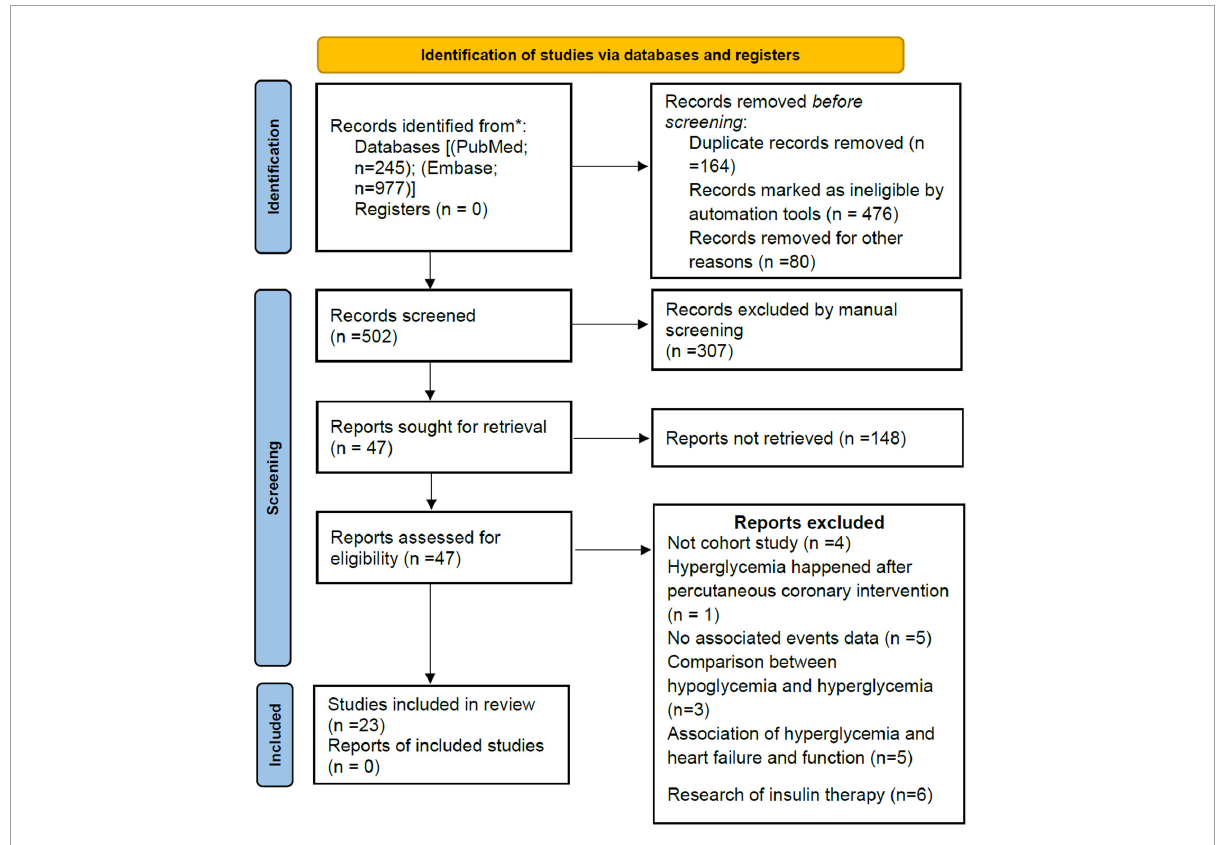
FIGURE1 PRISMA flow